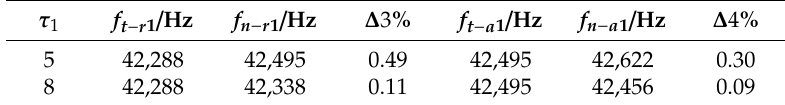
Table 3. Comparisons between the theoretical and simulation results of the No. 2 transducer at τ = 1